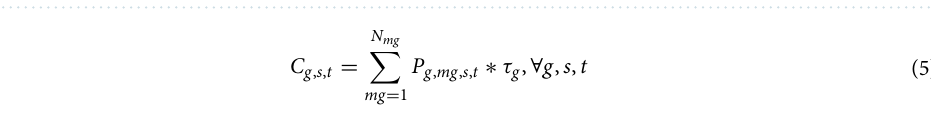
Figure 2. Structure of cyber-physical distribution